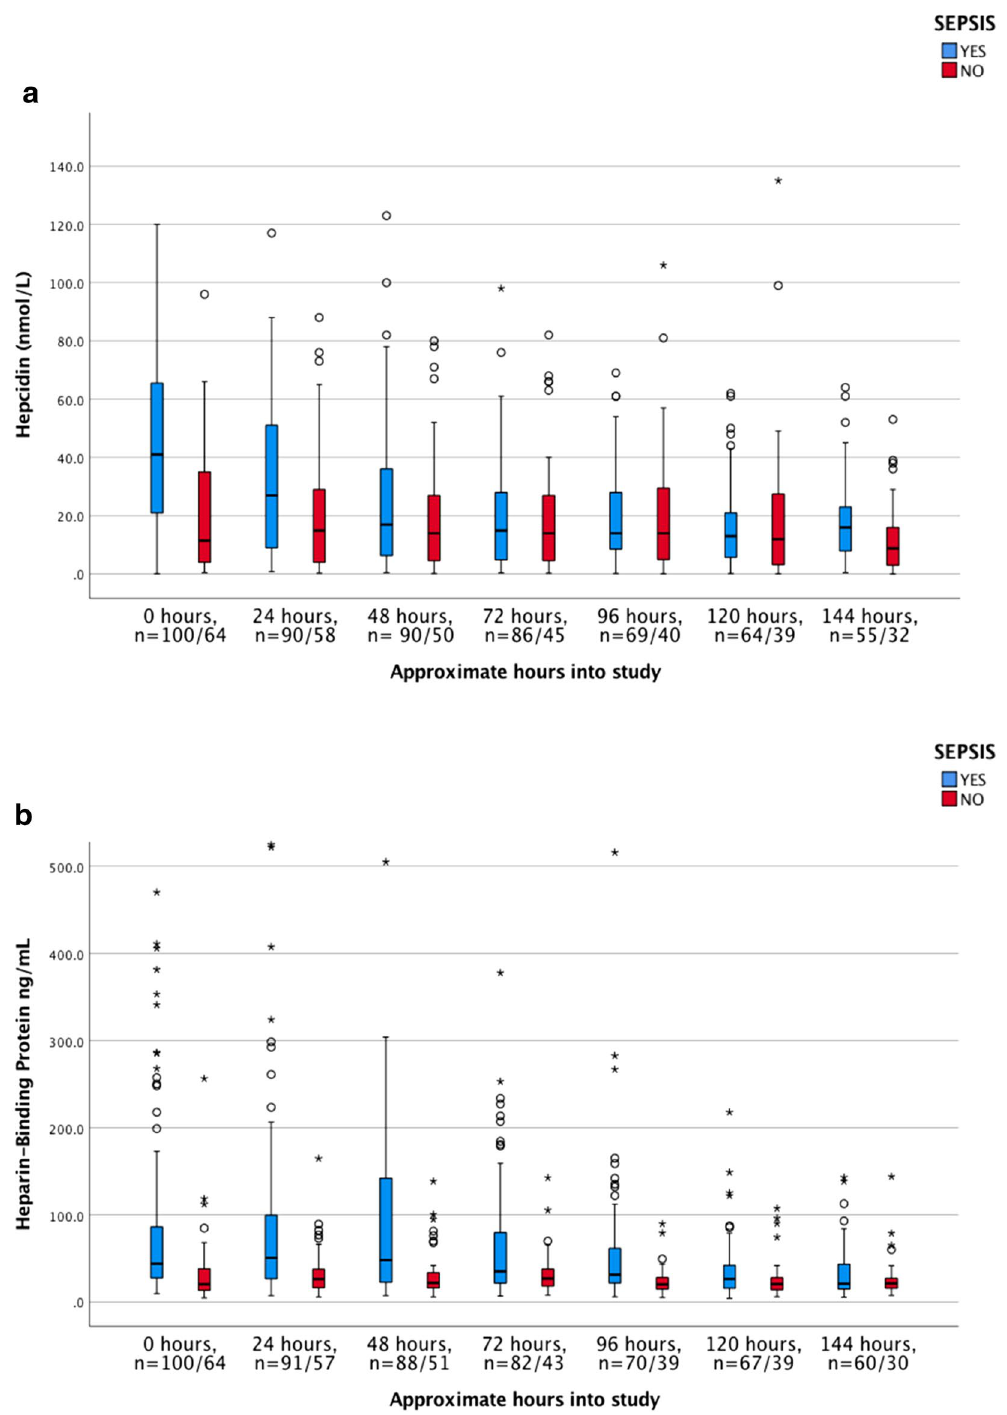
Figure 2. ( a – f ) Dynamics of biomarkers during the study period. Boxplot. [hepcidin, HBP, CRP, PCT, lactate and white blood count (WBC). Due to de-escalation of y-axis a few extreme- and ordinary outliers are not visualized in Fig. 3a–f. n = numbers, sepsis versus non-sepsis, respectively. Missing data occurred occasionally at single time points distributed between both septic and non-septic